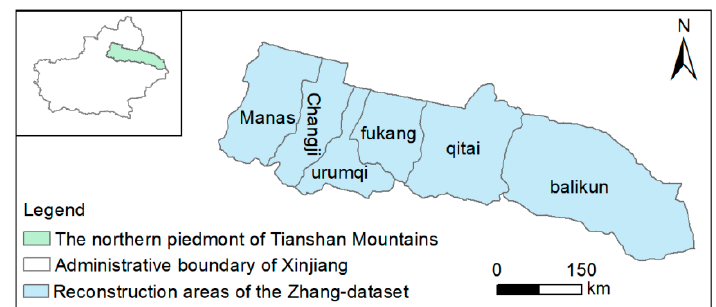
Figure 2. Reconstruction regions of the Zhang